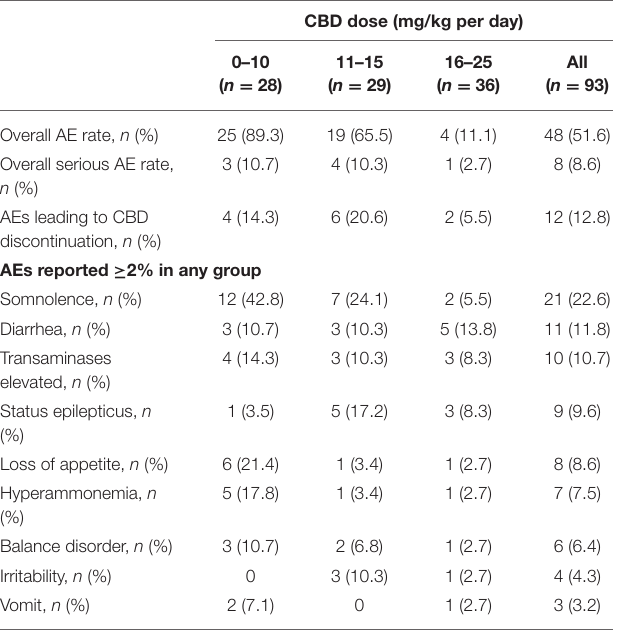
TABLE 6 | Summary of adverse events in safety